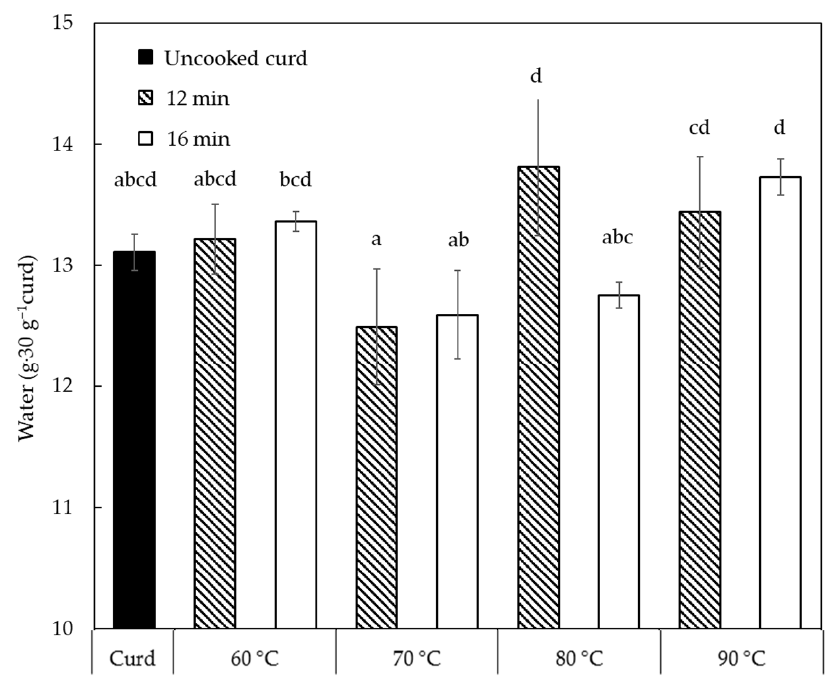
Figure 2. Water content retained in 30 g curd at varied cooking temperatures for 12–16 min. Values with different superscripts differ significantly ( p < 0.05). The error bars indicate standard deviations. Fat was the main component lost into the cooking water, which at maximum decreased from 8.1 g to 6.6 g in 30 g curd for 80 ◦ C as cooking time increased up to 16 min (Figure 1e). Longer cooking resulted in increased curd temperature and thus enhanced fat